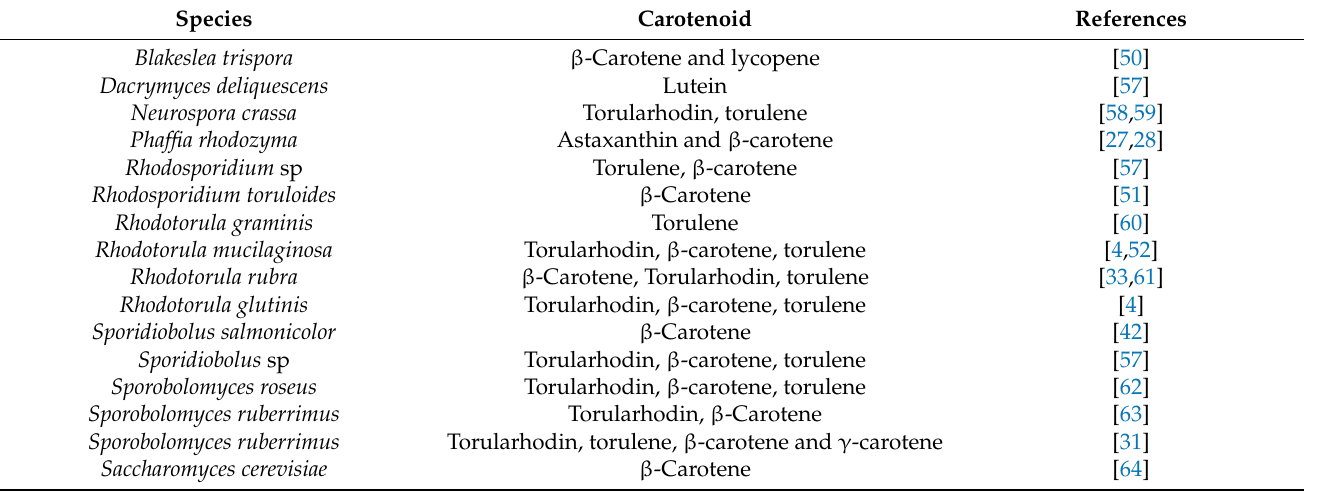
Table 1. Main carotenoids produced by fungi by biotechnological